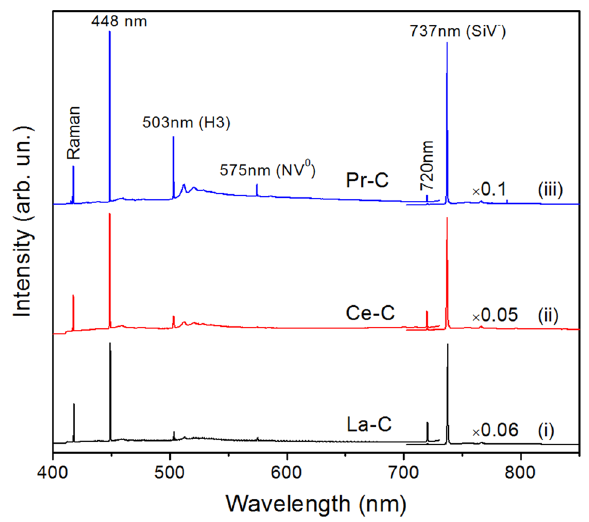
Figure 5. Representative PL spectra of diamonds produced using light rare-earth metal catalysts. The spectra were recorded at 80 K with excitation of 395 nm for diamonds synthesized in (i) La–C, (ii) Ce–C and (iii) Pr–C systems at 2000 °C. The spectra were normalized to show the same intensity of the diamond Raman peak and displaced vertically for clarity. The near-infrared parts of the spectra were multiplied by factors of (a) 0.06, (b) 0.05 and (c)